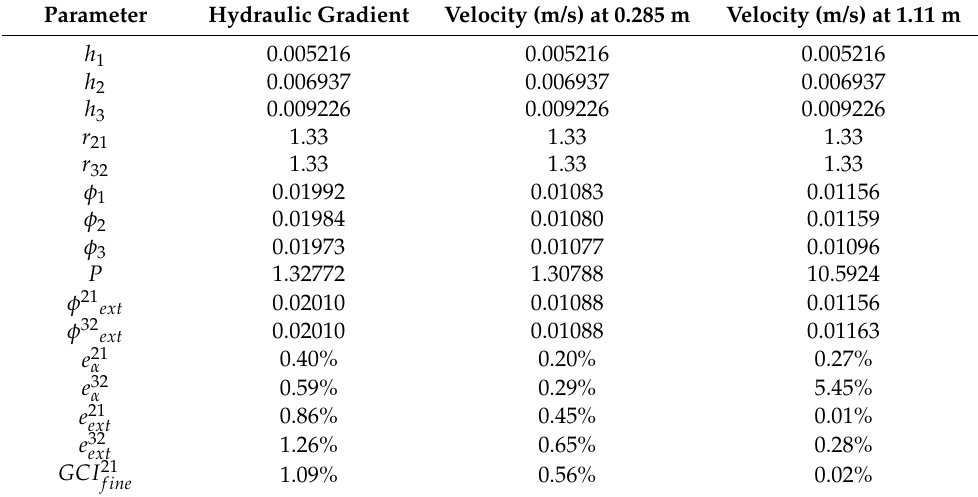
Table 4. Sample calculations of numerical uncertainty using the GCI method